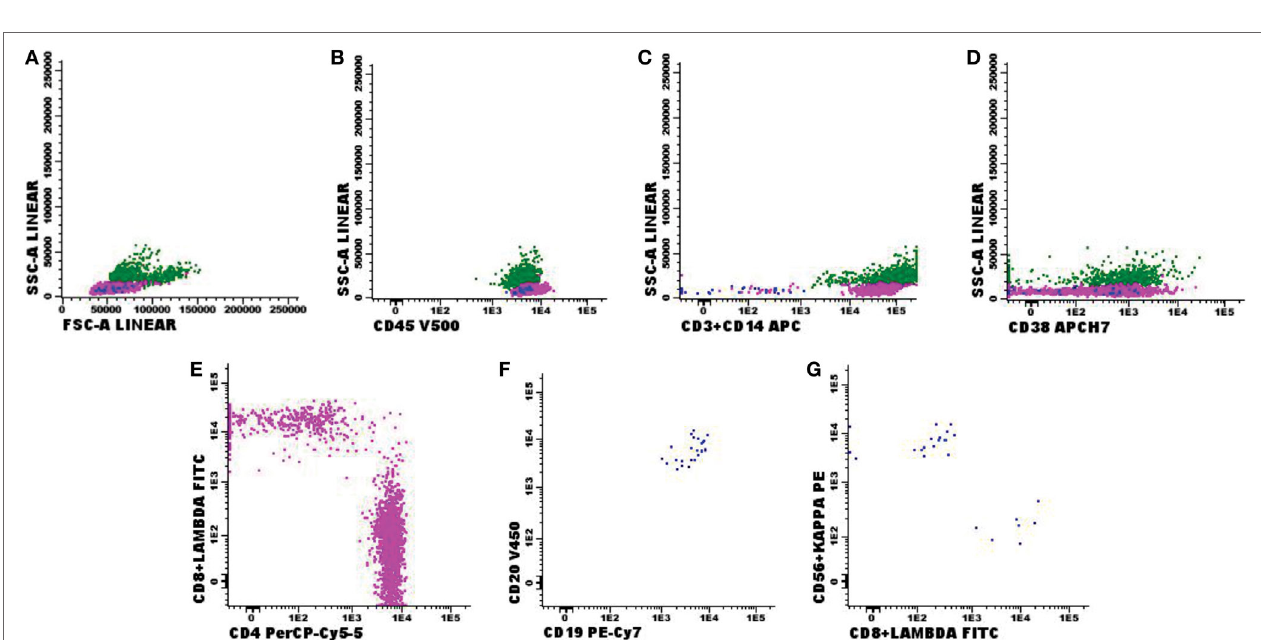
FigUre 1 | Negative flow cytometry result for suspected central nervous fluid (CSF) infiltration by hematological malignancies. Presumptive diagnosis: central nervous system disorder. (a,b) Normal forward-scattered light (FSC size) and side-scattered light (complexity—SSC); (c–e) normal antigenic expression of CD3 in T-lymphocytes, CD4 and CD8 expression in CD3 + CD4 + and CD3 + CD8 + lymphocyte subtypes, CD14 expression in monocytes and CD38 expression and CD56 + CD3 − natural killer (NK) cells; (F,g) polyclonal CD19 + CD20 + B-lymphoid population for kappa (73%) and lambda (27%) light chains. Sample with 3 leukocytes/ mm 3 and 1 red blood cell/mm 3 , acquisition of 8,425 events in the FACS Canto II (Becton Dickinson), and analysis performed with the software Infinicyt (Cytognos). The frequency of populations in the viable cell region and CD45 + (3,385 events) was 68.6% CD3 T-lymphocytes—in that, 52.6% CD4 T-lymphocytes and 13.9% CD8 T-lymphocytes; 0.9% NK cells; 0.7% mature and polyclonal B-lymphocytes (kappa/lambda ratio: 2.38); and 29.8% monocyte lineage cells.